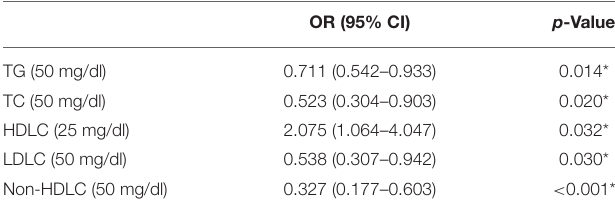
TABLE 2 | Multivariate-adjusted # OR and 95% CI of lipid levels for poor 3-month outcome (mRS ≥ 3).